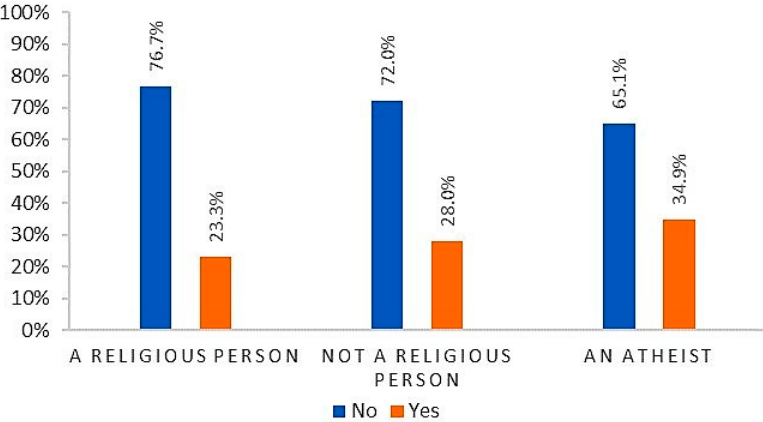
Figure 21. Self-declared religiosity and engaging in informal practices.